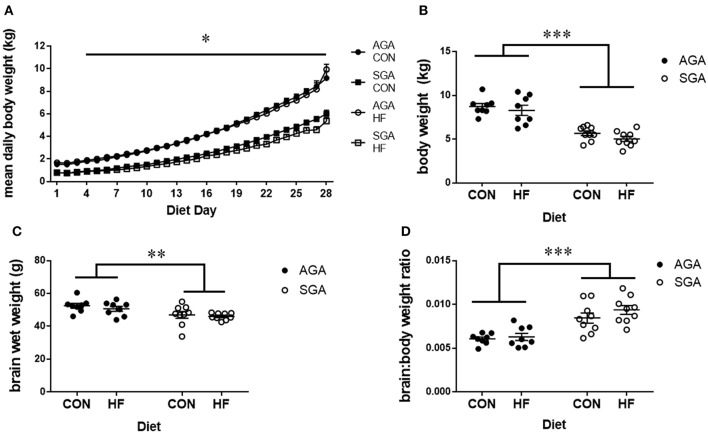
Brain and body weights of piglets fed a control or HF formula. Body weight was measured each morning (A). SGA piglets gained weight in a similar pattern but a slower rate than AGA. AGA piglets began gaining weight at day 4, while SGA piglets did not show appreciable weight gains until day 7. AGA piglets outweighed SGA piglets every day for the remainder of the study starting at day 4. Diet did not affect piglet weight gain. SGA piglets weighed less than AGA on the day of MRI regardless of diet (B). Brain weights taken after the MRI showed that SGA piglets had smaller brains (C). The brain to body weight ratio was greater in SGA piglets. There were no effects of diet on brain weights or brain to body weight ratio (D). AGA, appropriate for gestational age; SGA, small for gestational age; CON, control; HF, hydrolyzed fat. Data are presented as mean ± SEM, AGA n = 8 per group, SGA n = 9 per group. ***p < 0.001, **p < 0.01, *p < 0.05.